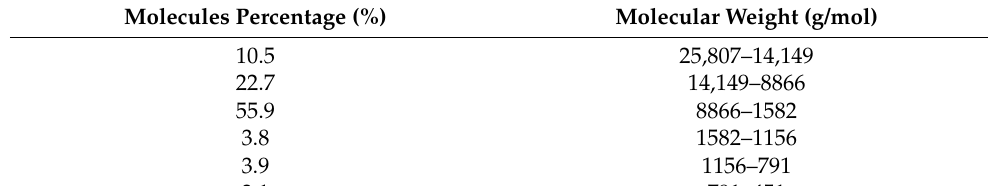
Table 2. Molecular weight distribution of grape skin extracts.